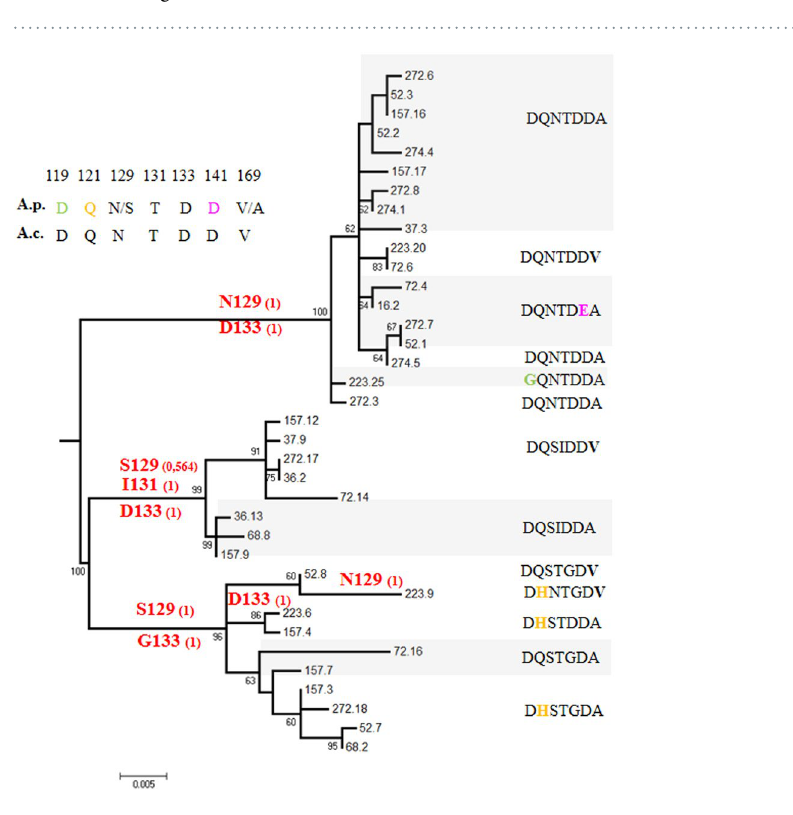
model in which independent duplications arose probably in response to the gradual appearance of epibiosis, suggesting that the ancestor was not fully equipped to sustain durable interactions with existing microbial com- munities. Tandem duplications seem to have been the most appropriate mechanism for the long-term acquisition of a strict complex multi-specific epibiosis. Series of intra- and inter-genic ‘natural’ recombinants were also identified, mainly in the first part of the pre- proalvinellacin gene without exon shuffling or deleterious frame-shifts of the coding sequence. Natural intergenic recombinants are rarely present in tandemly duplicated genes because of concerted evolution 55 . In the immune system, however, recombination seems to play a positive role in producing allelic diversity as previously shown for MHC class I genes 56 . Successful recombination events have been frequent in the preproalvinellacin gene since the